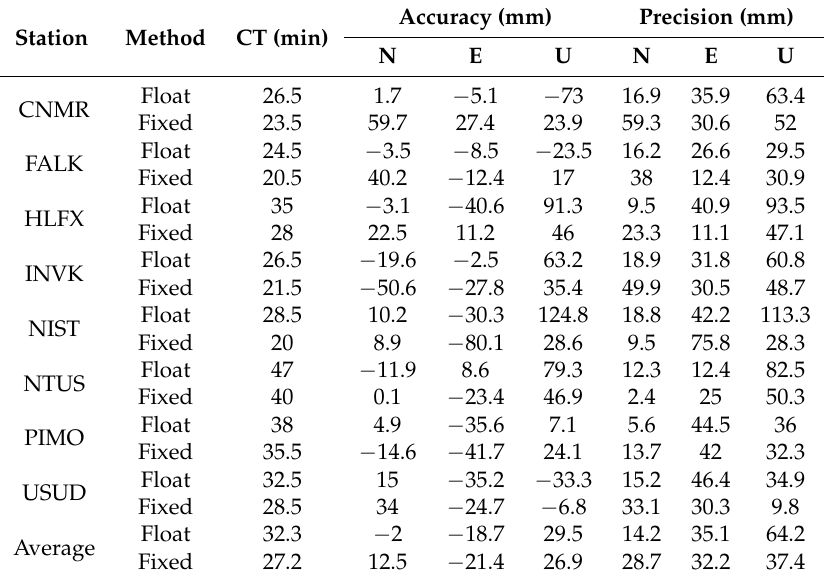
Table 3. Positioning performance at different stations in the post-processing